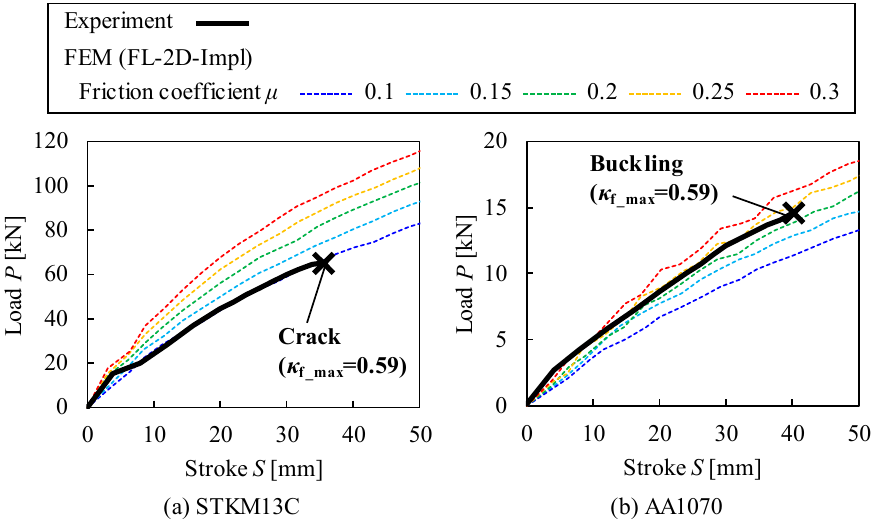
Figure 9. Load P vs. stroke S diagram for tube flaring.